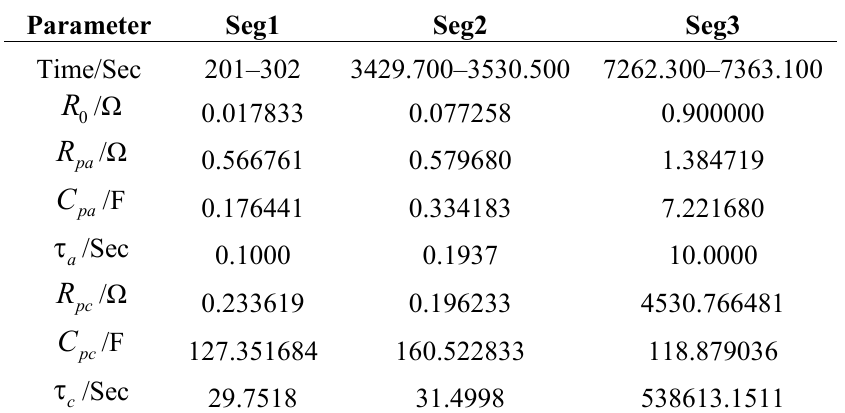
Figure 8. The equivalent model parameter identification results and their errors: ( a ) The measured transient voltage and its simulation result using the identified model parameters; ( b ) Simulation errors due to parameters identification errors. Table 3. Equivalent model parameter identific0ation